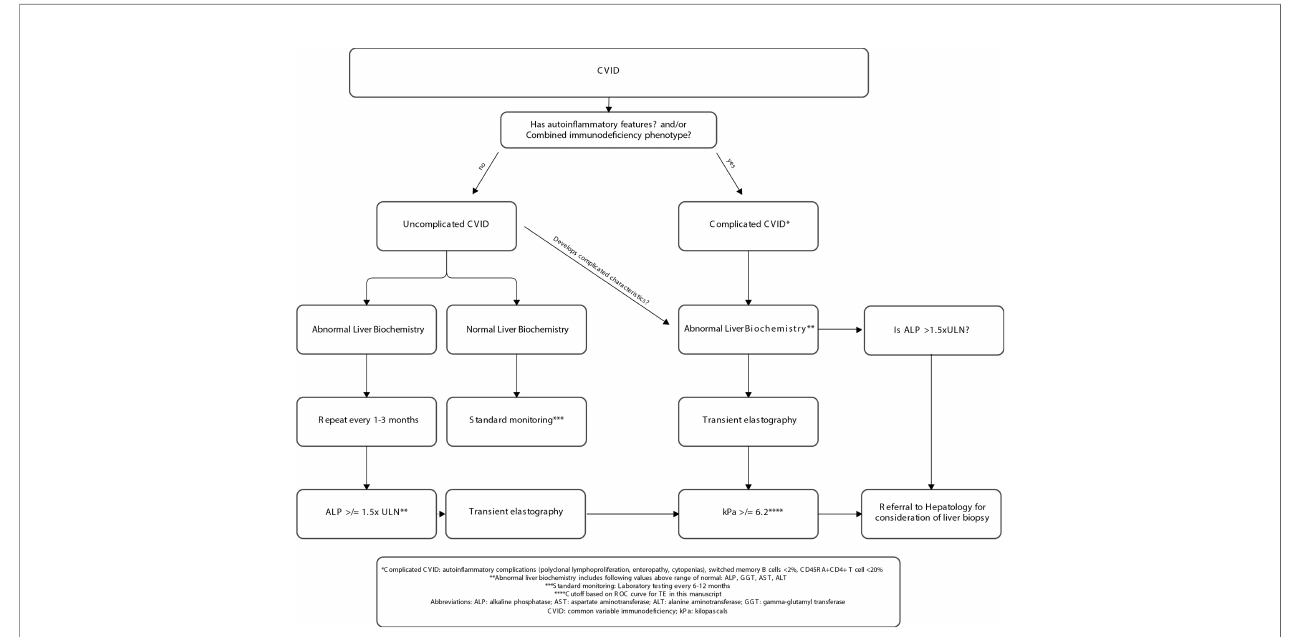
FIGURE 5 | Clinical algorithm for early detection of nodular regenerative hyperplasia in individuals with CVID. CVID, common variable immunode fi ciency; ULN, upper limit